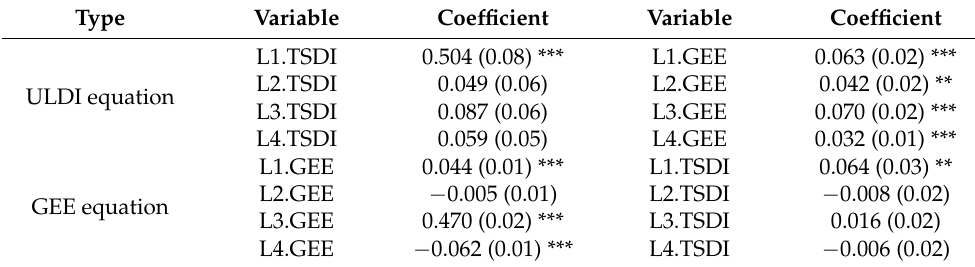
Table 6. Estimation results of PVAR model based on GMM